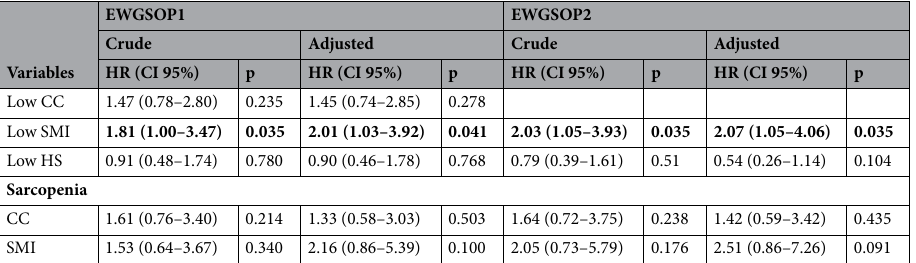
Table 3. Crude and adjusted cox regression analysis between the parameters of sarcopenia, by the EWGSOP1 and EWGSOP2 sarcopenia criteria, according to two muscle mass measuring methods and 10-year all-cause mortality risk. Adjusted for: age, sex, smoking, physical activity, and diabetes mellitus. HR hazard ratio, CI confidence interval, CC calf circumference, SMI skeletal muscle mass index, HS handgrip strength, EWGSOP European Working Group on Sarcopenia in older people. Significant values are in